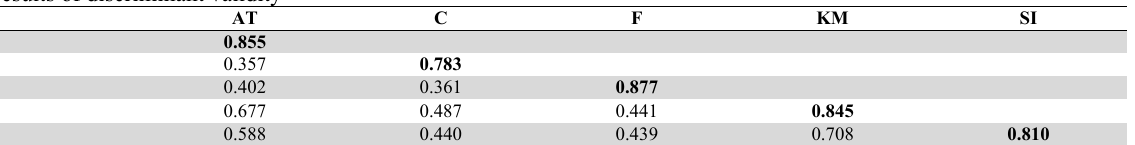
The results of discriminant validity